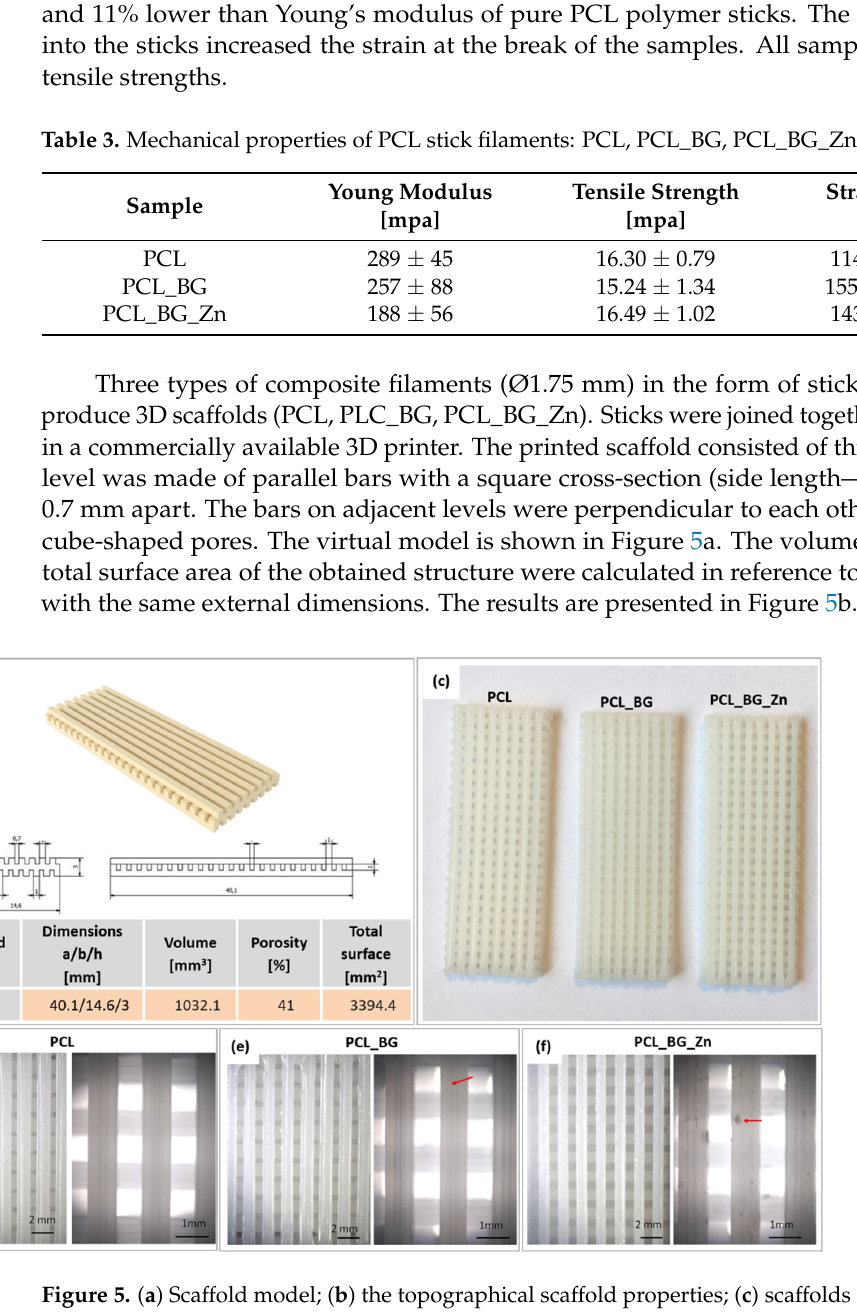
Table 3. Mechanical properties of PCL stick filaments: PCL, PCL_BG,